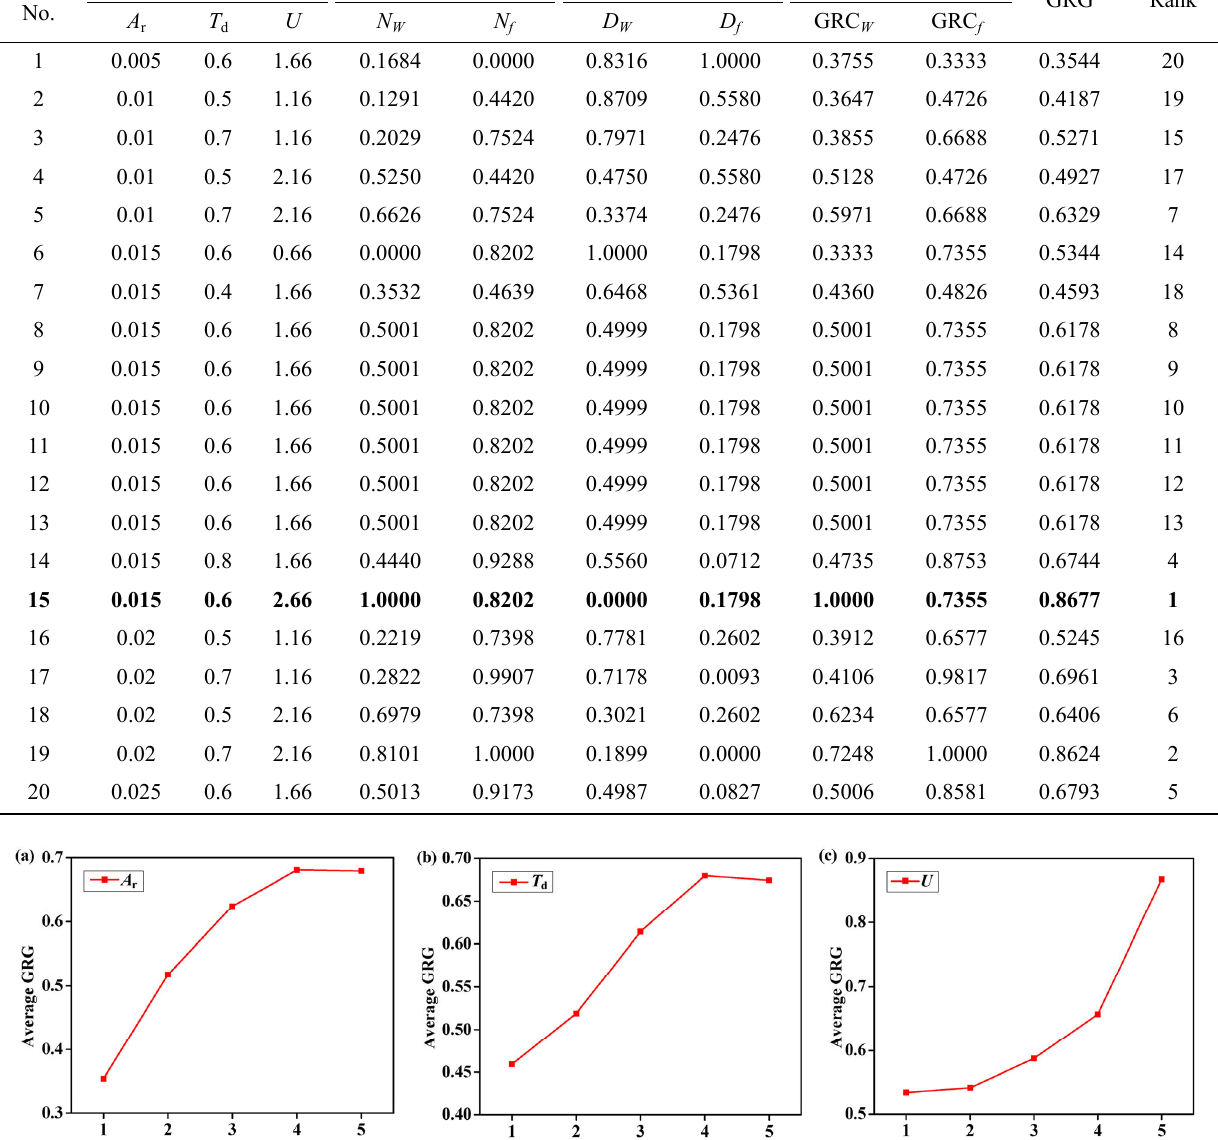
Fig. 14 Influence of triangle T2 bottom profile texture design variables: (a) aspect ratio, (b) texture density, and (c) flow speed on output